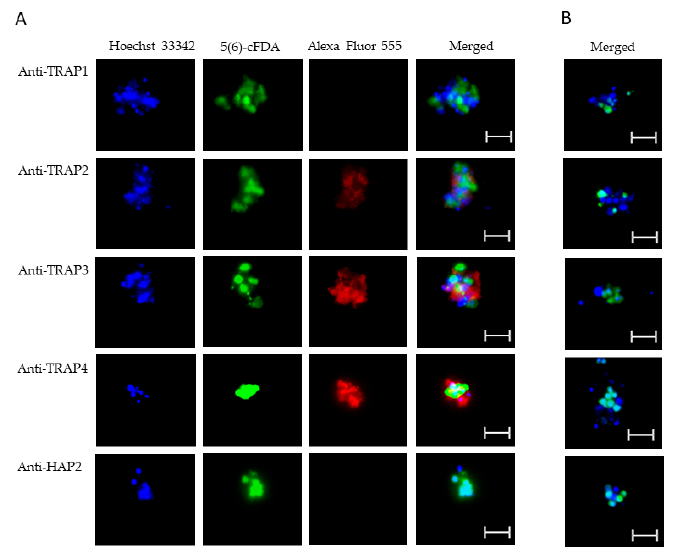
Figure 5. Evaluation of surface expression of TRAP proteins by B. bovis blood stages using a live immunofluorescence assay incubated with anti-TRAP 1, 2, 3, 4, or HAP2. Panels are ( A ) immune and ( B ) pre-immune rabbit serum. Blue indicates Hoechst 33342 stained DNA, green indicates live, intact exoerythrocytic parasites retaining 5(6)-cFDA, and red indicates anti-rabbit IgG Alexa Fluor 555 reactivity. Scale bar: 5 µm.